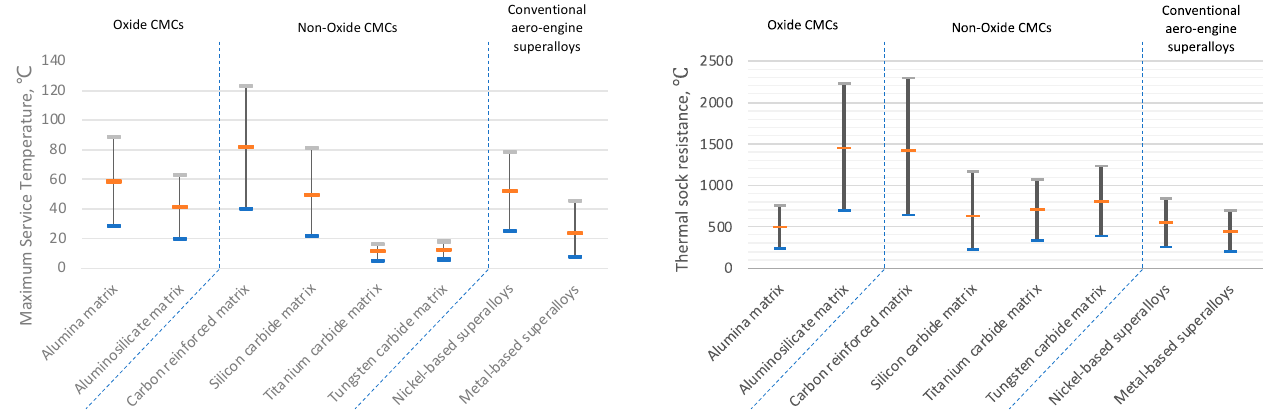
Figure 14. Comparison of ( left ) maximum service temperature and ( right ) thermal shock resistance